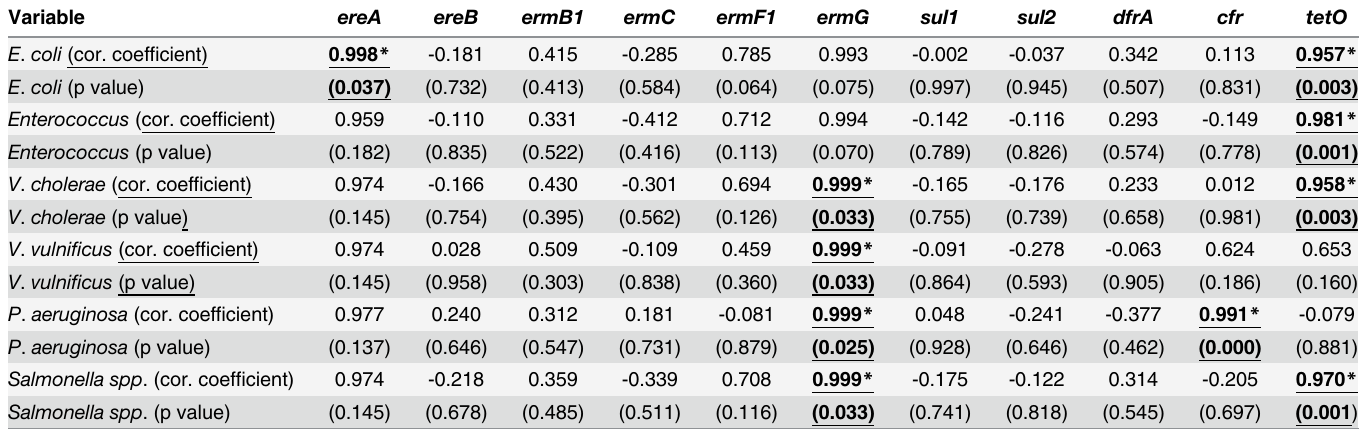
Table 7. Pearson correlation analysis of ARGs to indicator organisms from ballast and harbor